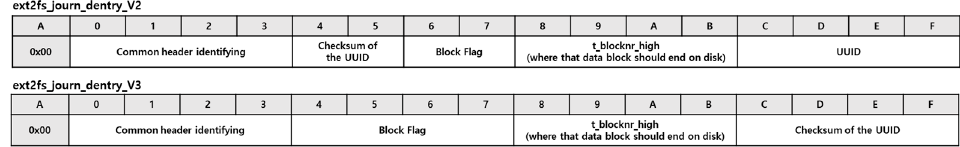
Figure 3. Journal descript block and journal block tag structure of Ext4 file system.